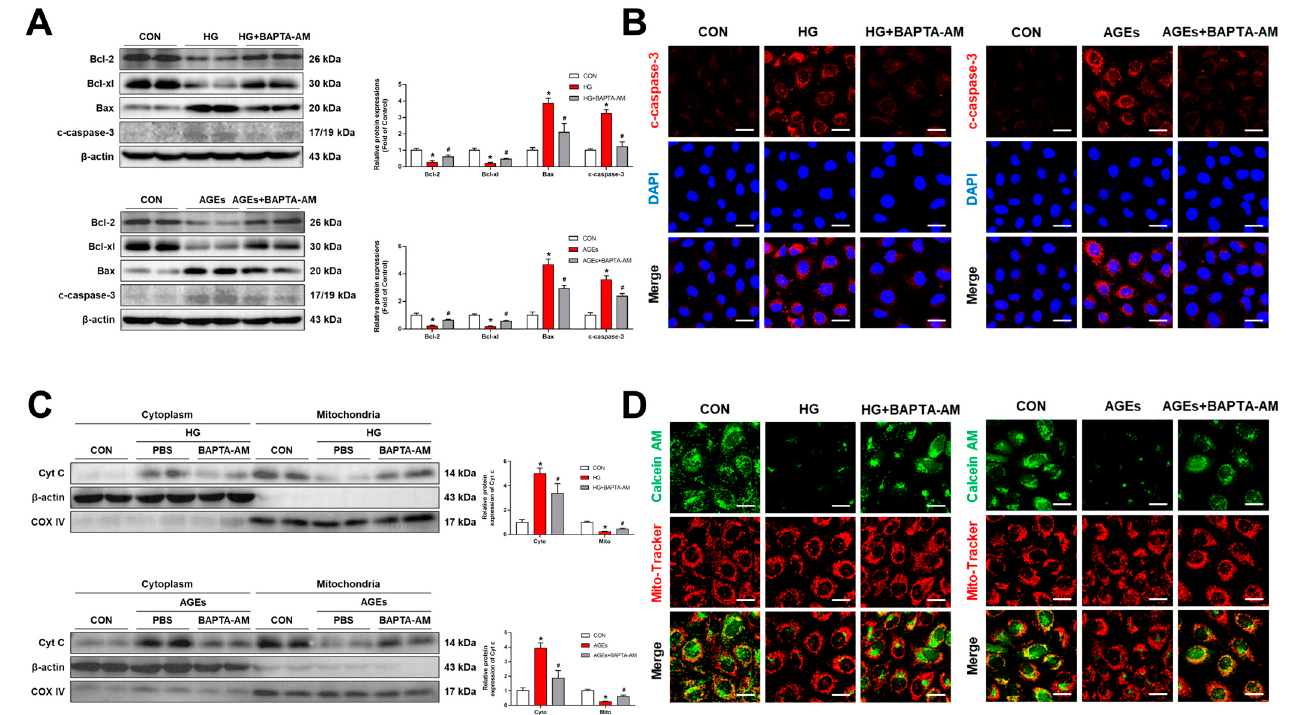
Figure 4. Mitochondrial Ca 2+ induced RMECs apoptosis. RMECs were pretreated with BAPTA-AM (10 µ M) for 2 h, then stimulated with HG (33 mM) or AGEs (200 µ g/mL) for 48 h. ( A ) Apoptosis- related proteins (Bcl-2, Bcl-xl, Bax, and cleaved caspase-3) were assessed through Western blotting. ( B ) Cleaved caspase-3 was performed in a representative immunofluorescence assay. Scale bars = 25 µ m. ( C ) Cyt c expressions in mitochondrial and cytosolic fractions were measured through Western blotting. ( D ) To detect mitochondrial permeability transition pores (mPTPs), RMECs were loaded with a Calcein-AM dye (2 µ M) containing CoCl 2 (250 µ M) for 45 min. Mito-Tracker Red (200 nM, 30 min) was used to co-stain the mitochondria. Scale bars = 25 µ m. Results are presented as means ± SD. * p < 0.05 vs. control group, # p < 0.05 vs. HG or AGEs